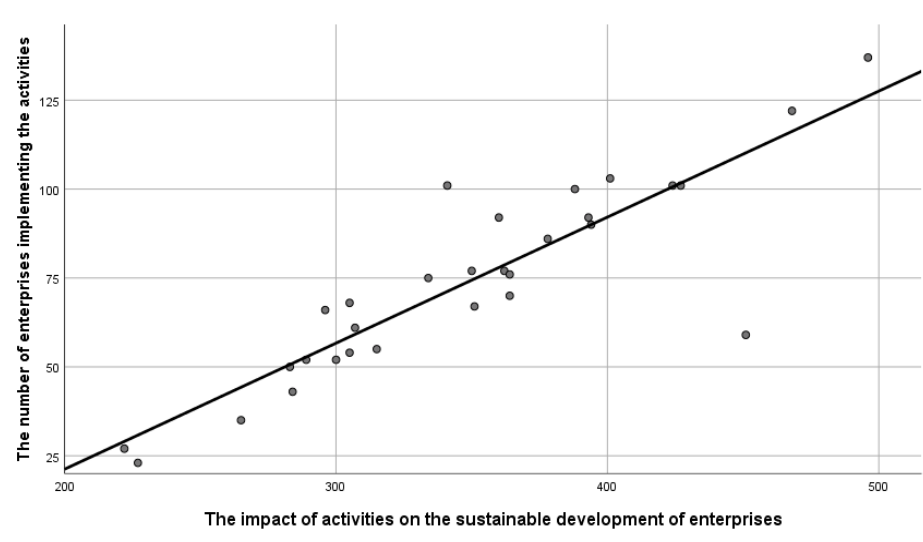
Figure 1. The correlation between the impacts of activities leading to the accumulation of GIC on the environmental development of the organization, and their implementations in the surveyed companies.